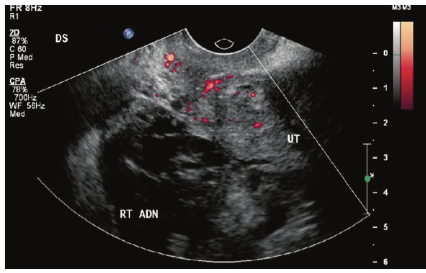
Figure 5: Pelvic ultrasound demonstrates a right adnexal mass (labeled RT ADN) adjacent to the uterus (labeled UT) with sur- rounding hypoechoic fluid suspicious for ectopic